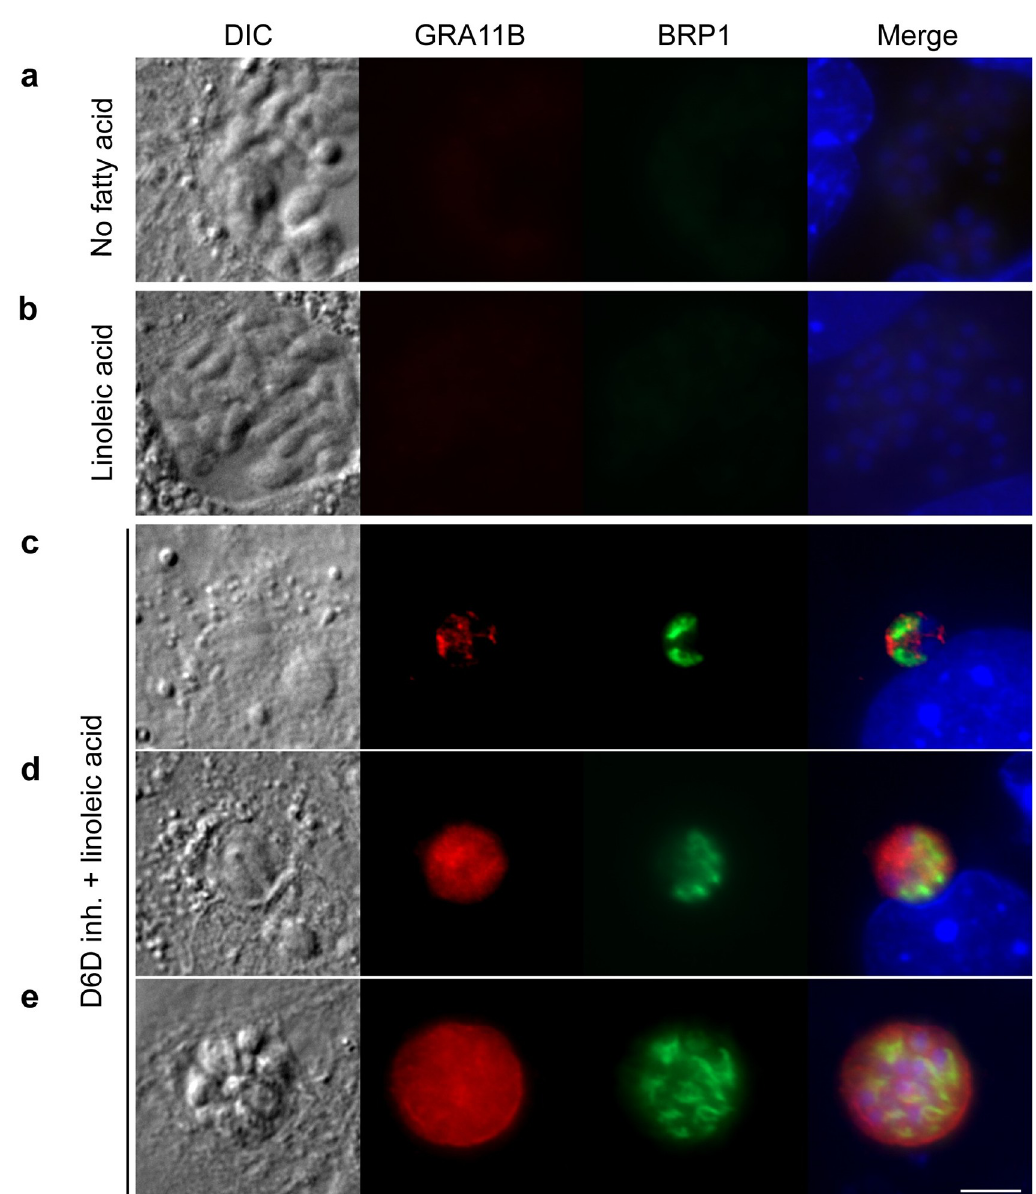
Fig 4. Inhibition of delta-6-desaturase permits sexual development in mouse culture. Mouse intestinal monolayers were incubated with either (a) no fatty acid supplementation, (b) 200 μ M linoleic acid, or (c, d, e) 200 μ M linoleic acid plus the delta- 6-desaturase inhibitor (“D6D inh.”) SC-26196 for 24 hours and then infected with ME49 bradyzoites for 5 days. Only in cultures supplemented with linoleic acid and SC-26196 were parasites undergoing presexual development detected by staining with GRA11B (red) or BRP1 (green). Parasites in (c) early, (d) middle, or (e) late stages of development were noted by differential localization of GRA11B. All panels are 20 μ m 2 with a 5- μ m white size bar in the lower right corner. BRP1, bradyzoite rhoptry protein-1; DIC, differential interference contrast; GRA11B, dense granule protein 11B.